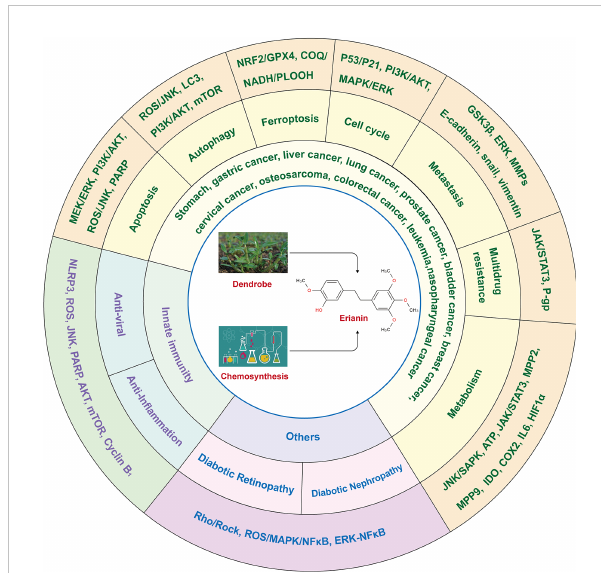
FIGURE 1 The structure and role of ERIANIN. The Chemdraw-Chem3D showed the secondary structure of ERIANIN. ERIANIN play a role in anti-tumor, anti-viral, anti-in fl ammation and the others pharmacological function by regulating the different biological phenotypes through the indicated